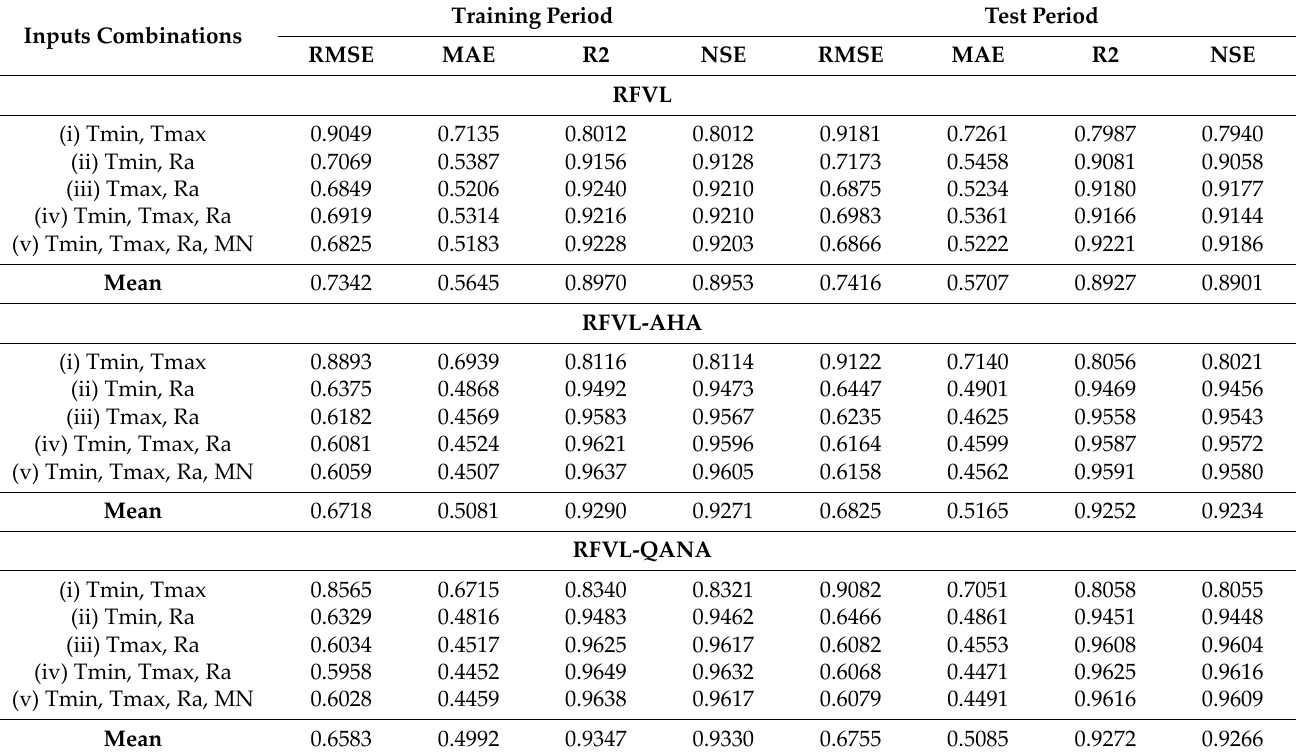
Table 3. The results of the RFVL‑based models for Faisalabad Station using the best training‑test partition (75–25%